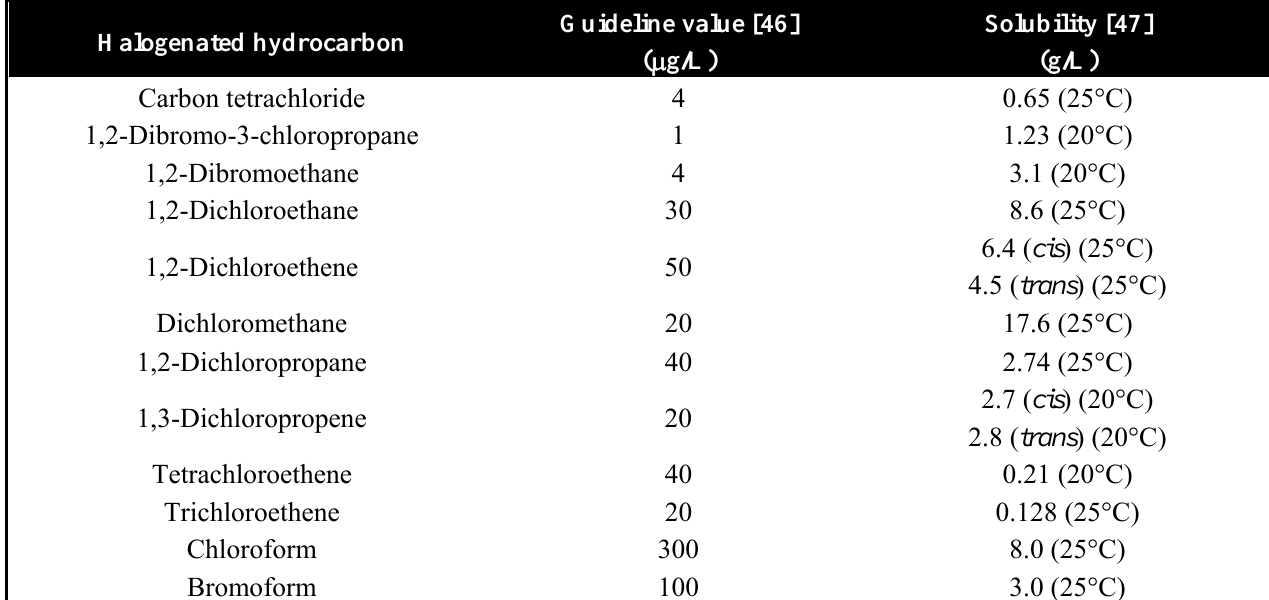
Table 3. The drinking water guideline value and solubility of some selected halogenated hydrocarbons. Halogenated